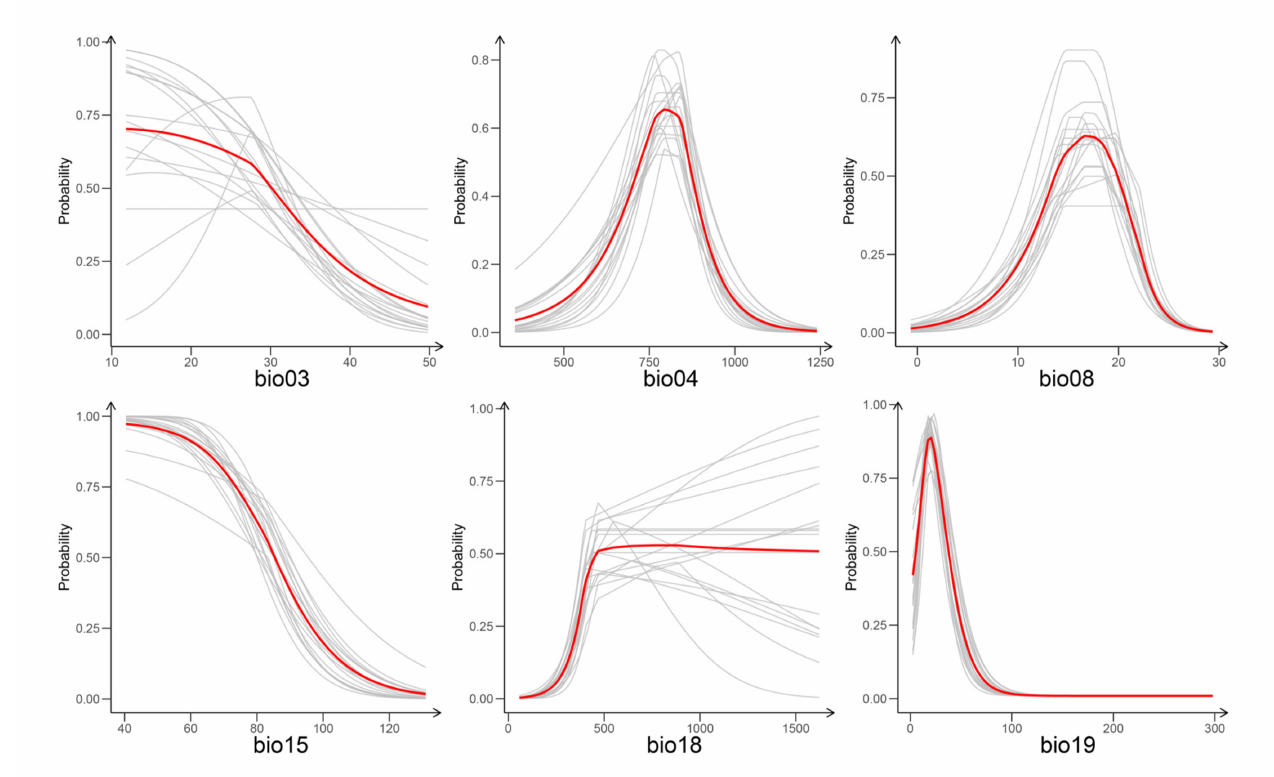
Figure 2. Response curves of 6 bioclimatic variables. We choose 18 MaxEnt models (with TSS > 0.8) and the ensemble model based on the 18 individual models to generate variable curves. The curve revealed by each individual model was drawn in grey, while a curve revealed by the ensemble model was drawn in